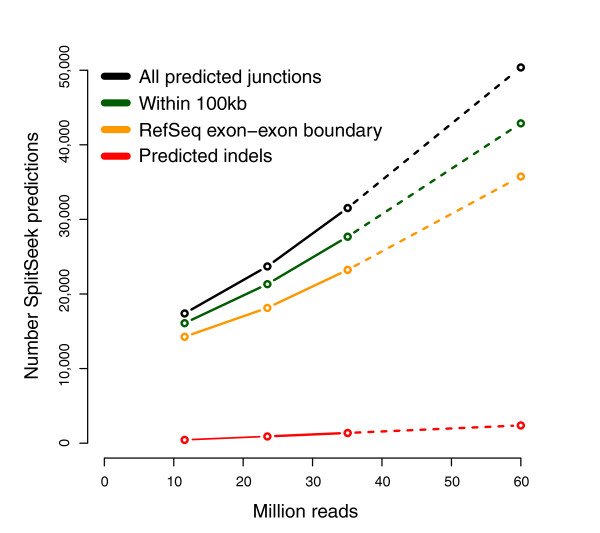
Number of predicted splice junctions (y-axis) as a function of the total number of processed reads (x-axis). The number of predicted junctions (black line) increases almost linearly with the number of reads. The green and orange lines represent two subgroups of predicted junctions: those where the two boundaries are separated by ≤100 kb, and those connecting two exon boundaries of a RefSeq gene. Predicted insertions and deletions are combined and represented by the red line.